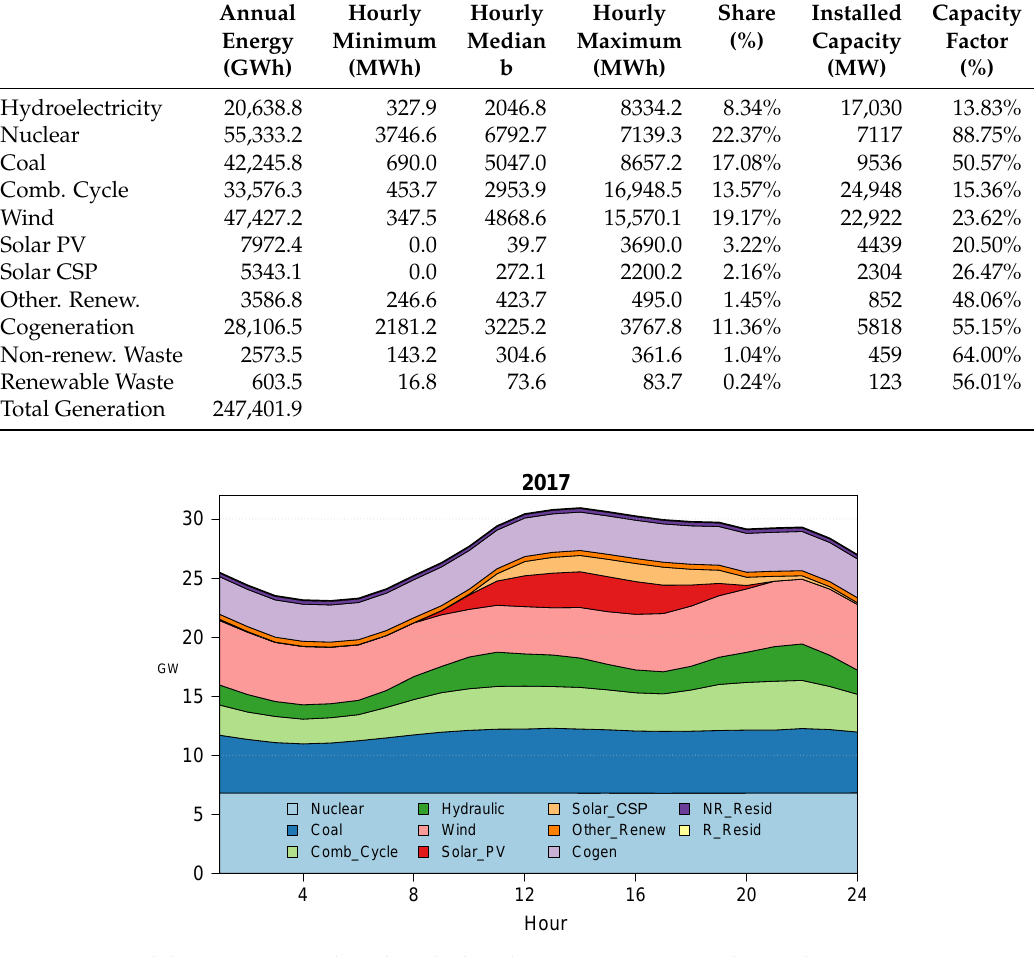
Figure 1. Breakdown generation based on the hourly average generation during the year 2017 in Spain. Source: authors based on the data from Red Eléctrica Española (REE)